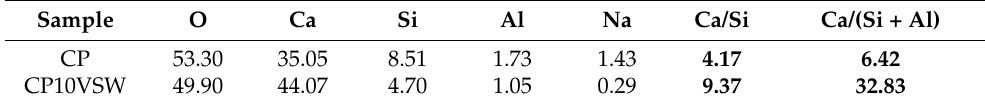
Table 2. Element concentrations (%) in CP and CP10VSW samples on the surface .